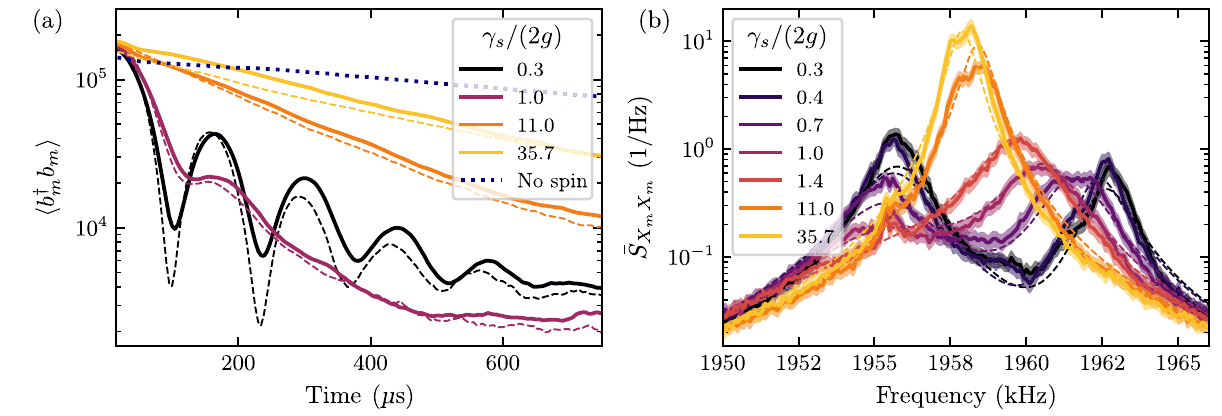
FIG. 2. (a) Time traces of the membrane occupation number after turning on the coupling to the atoms. The different traces show measurements with different spin damping rates γ and (2). The dotted line shows the membrane dynamics without atoms but with the coupling beam turned on. (b) Power spectral density of the membrane displacement. The dashed lines show a global fit to the data with the initial phonon occupation h b † and the detector shot noise level as global fit parameters and Ω independent calibrations. In (a) and (b), solid lines correspond to the mean and shaded areas to the standard deviation of 355